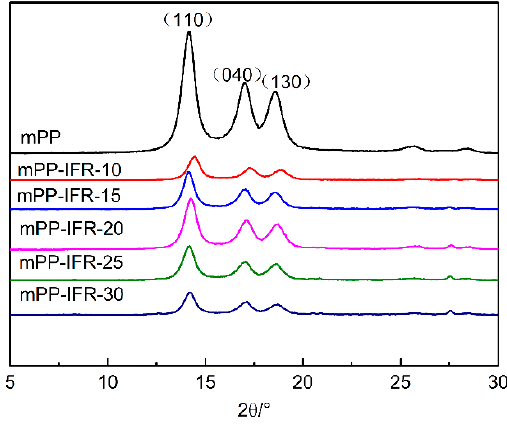
Figure 4. The XRD spectrum of the fibers. Figure 5 is 2D-WAXD diagrams of different fibers from polypropylene with different have three kinds of symmetric diffraction bright spots, which represents the orientation